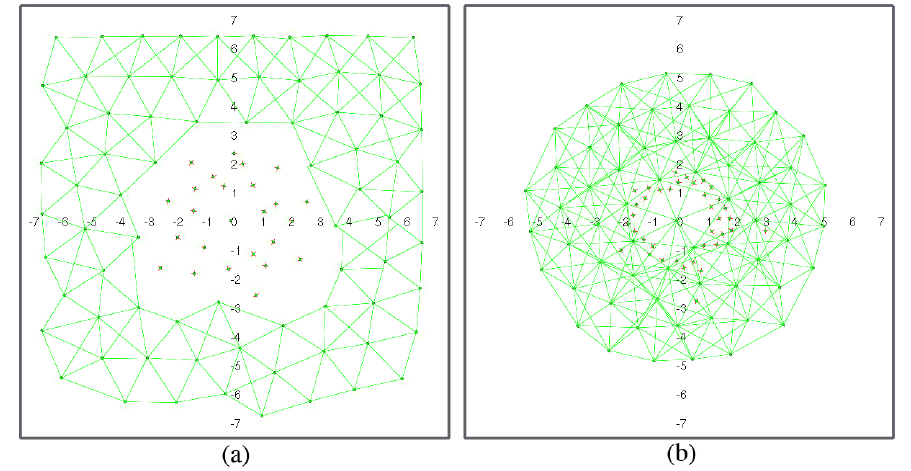
Figure 3. MWSN with geographic routing: ( a ) without clustering force; ( b ) with clustering force (figures are scaled 1:10